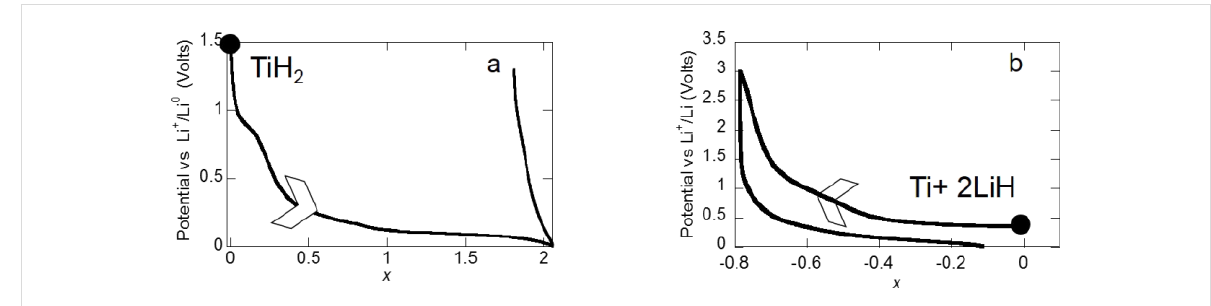
Figure 22: Potential profile of a) TiH 2 electrode ground for 5 h with 10% of C t , z carbon b) Ti + 2LiH electrode as a function of x , the mole fraction of Li (rate one equivalent of Li in 100 h). Adapted from [6]. Copyright 2009 Elsevier.